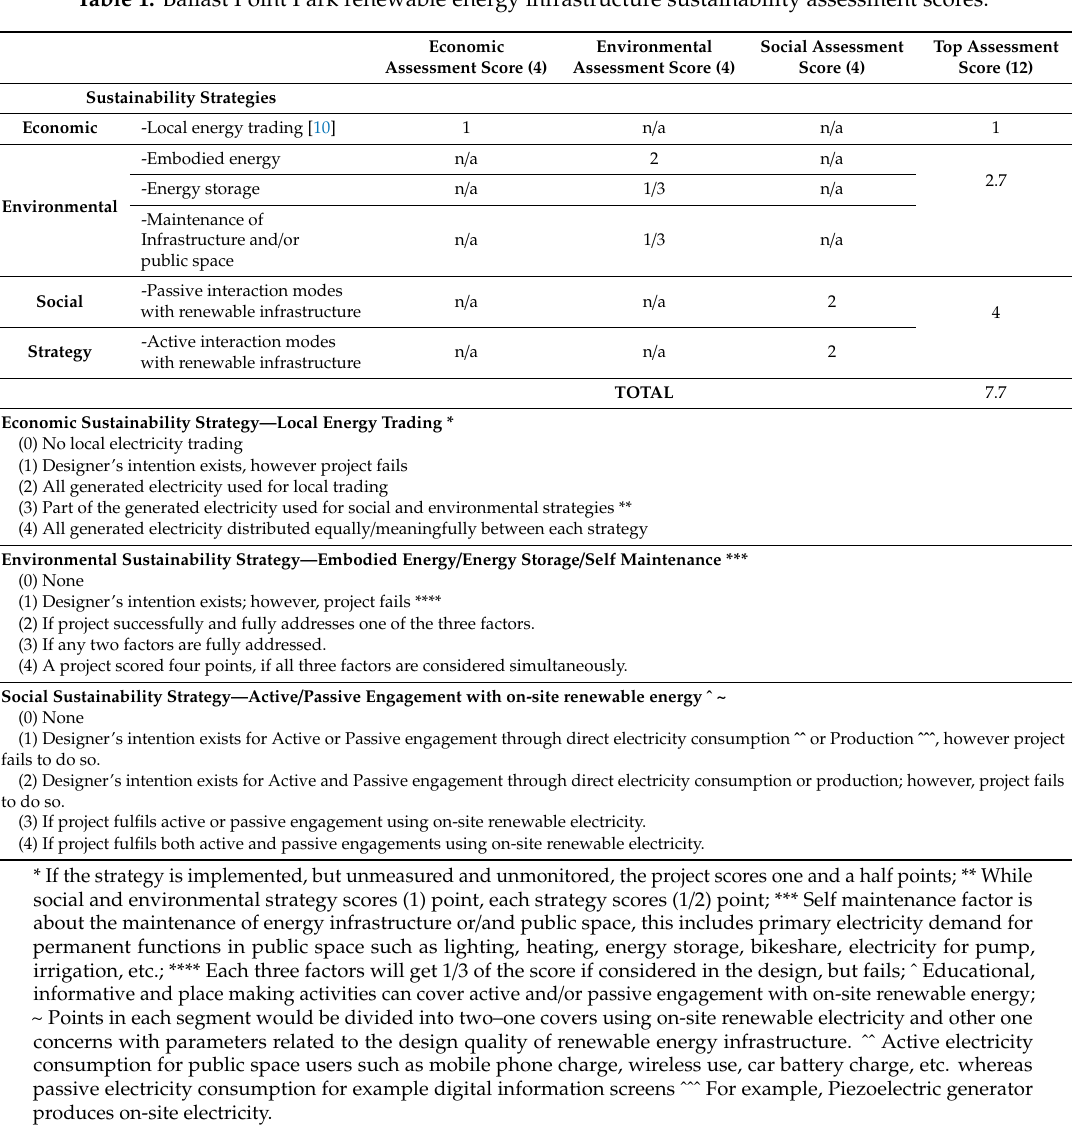
Table 1. Ballast Point Park renewable energy infrastructure sustainability assessment